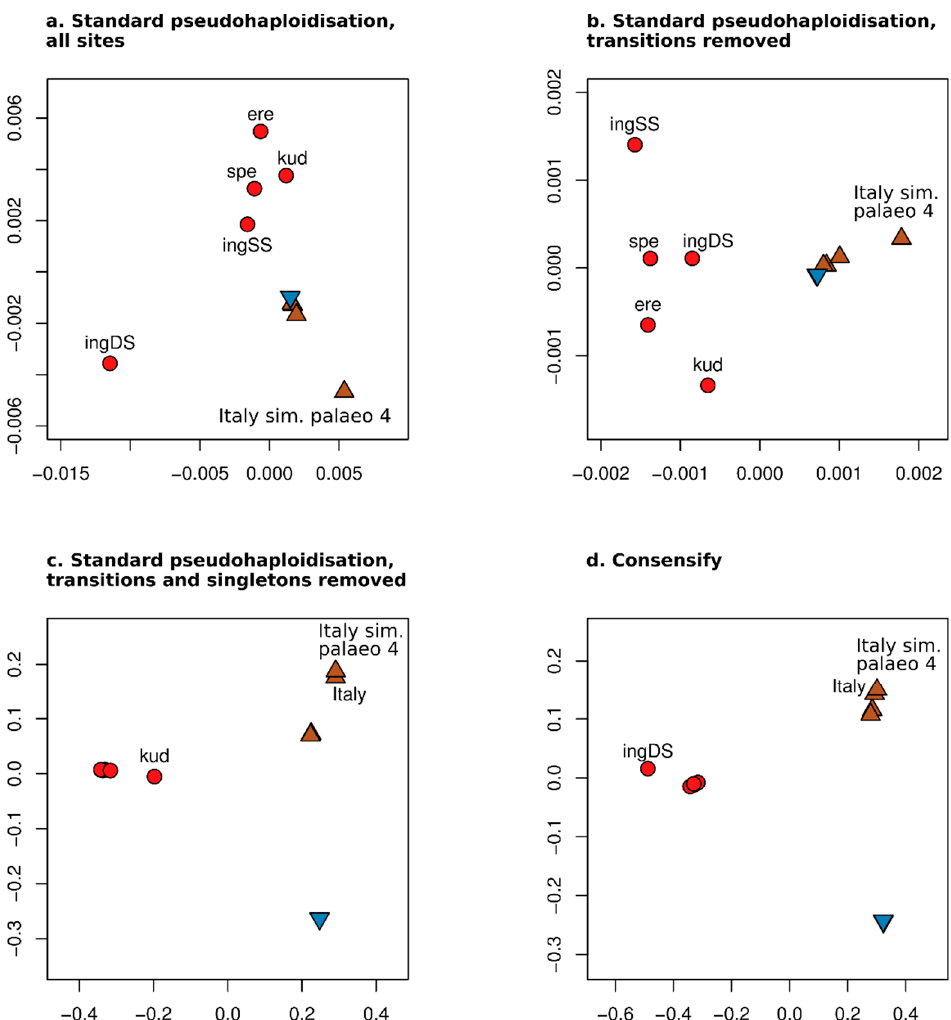
Figure 3. Effect of Consensify on population clustering analysis. Panels show the ordination of individuals along the first (x axes) and second (y axes) coordinates of a principal coordinates analysis based on ( a ) standard pseudohaploidisation using all sites, ( b ) with transitions removed, ( c ) with transitions and singletons removed, and ( d ) Consensify. Coloured symbols are consistent with Figure 1, and, where appropriate, individual cave bears are indicated by the first three letters of their taxon name. “ingDS” and “ingSS” indicate the ingressus datasets generated using double- and single-stranded library preparation methods, respectively. “Italy sim. palaeo 4” and “Italy” indicate the simulated palaeogenomic dataset with 35 bp fragment length, cytosine deamination and sequencing error, and the unmodified modern Italian brown bear dataset, respectively.